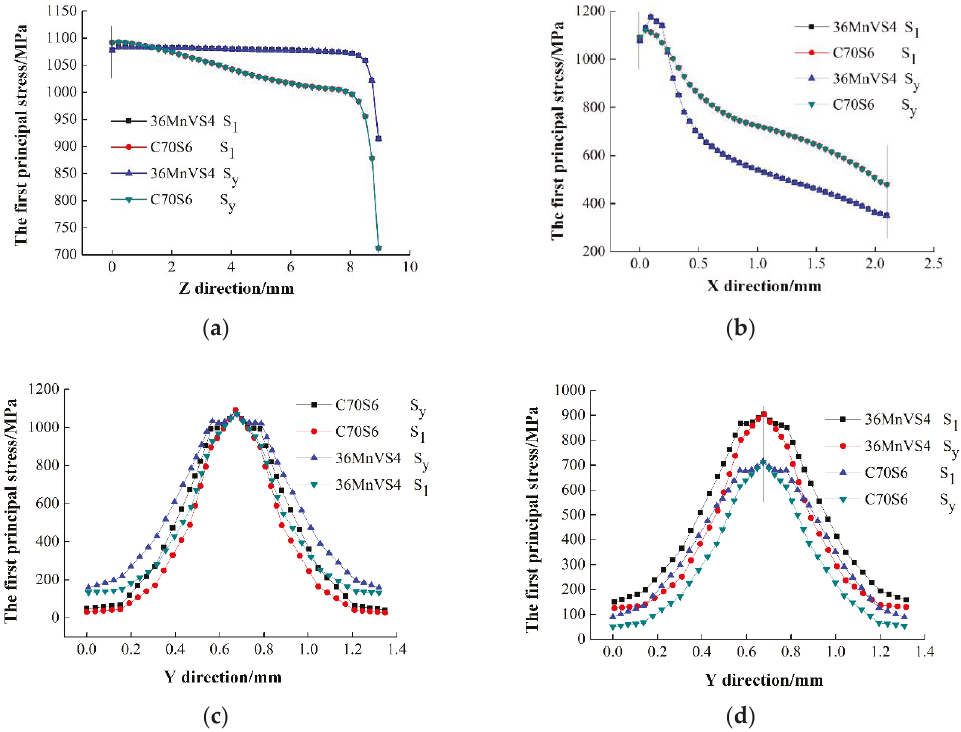
Figure 9. The stress of the feature lines in crack initiation: ( a ) Line 1; ( b ) Line 2; ( c ) Line 3; ( d ) Line 4.